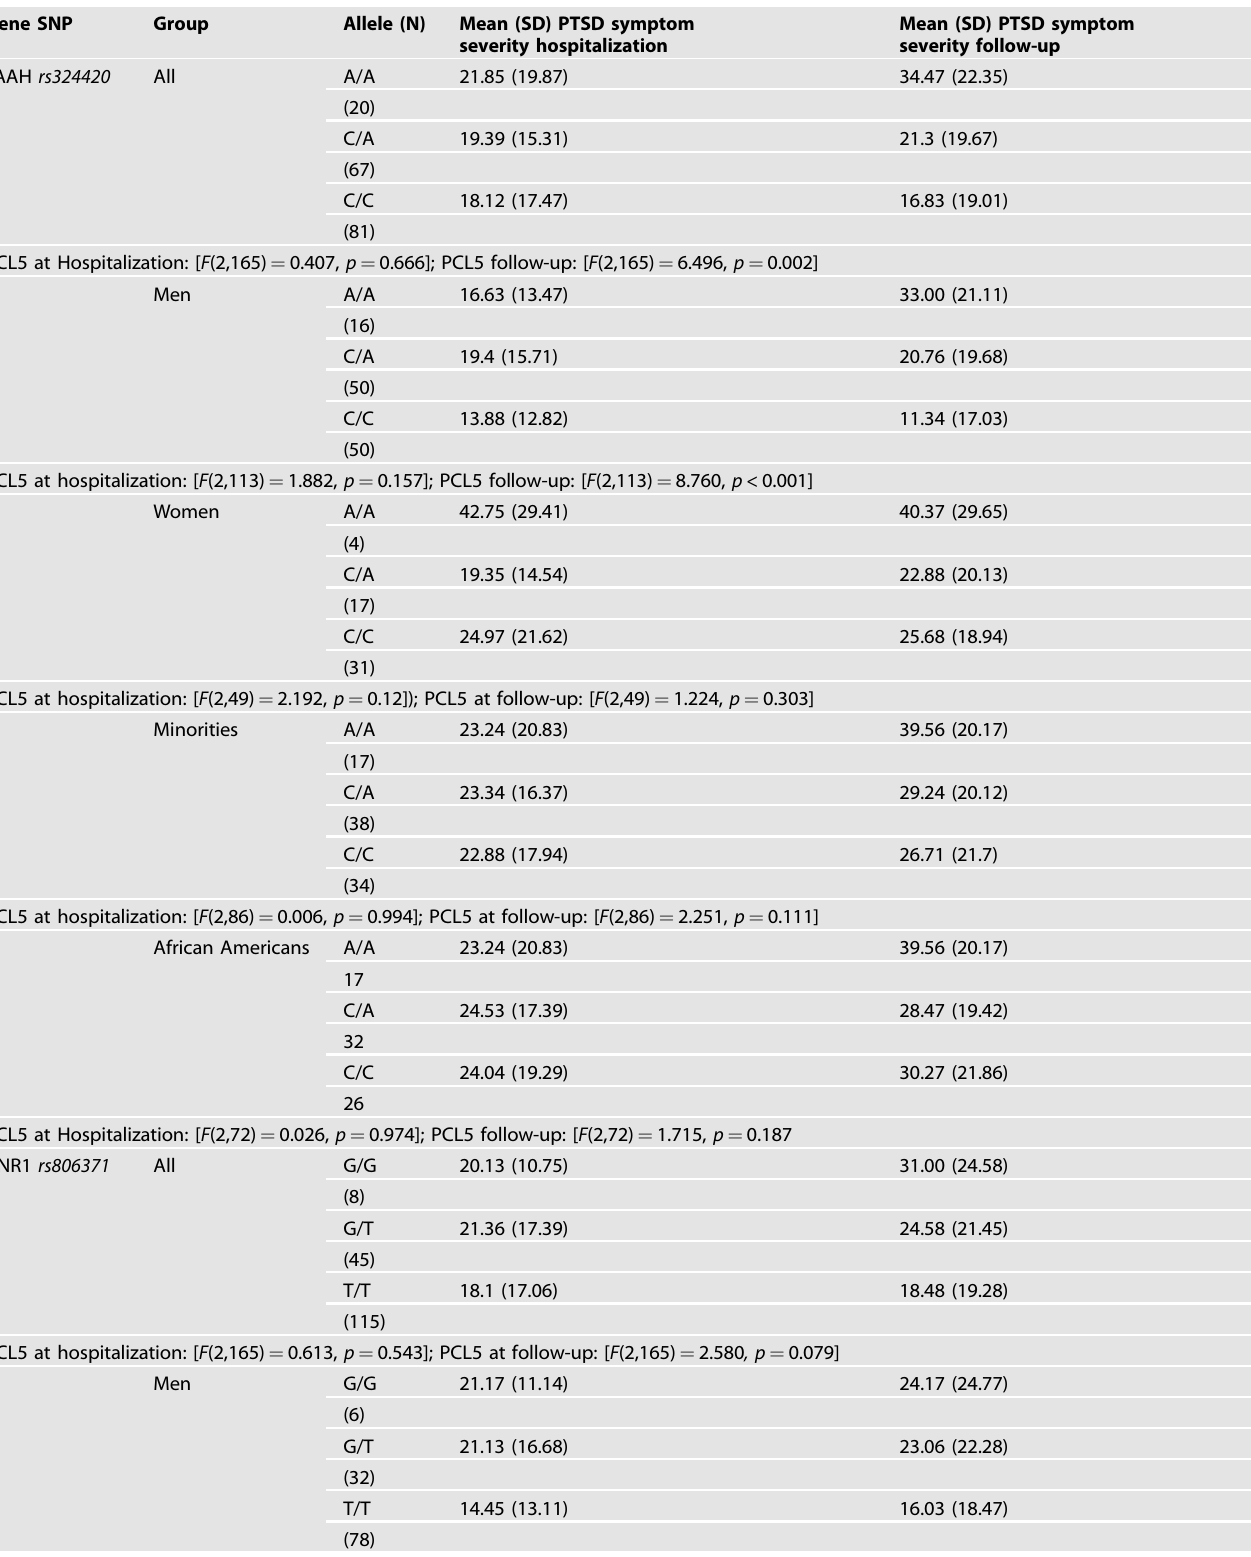
Table 2. PCL5 symptom severity at hospitalization and follow-up based on genotype. Gene